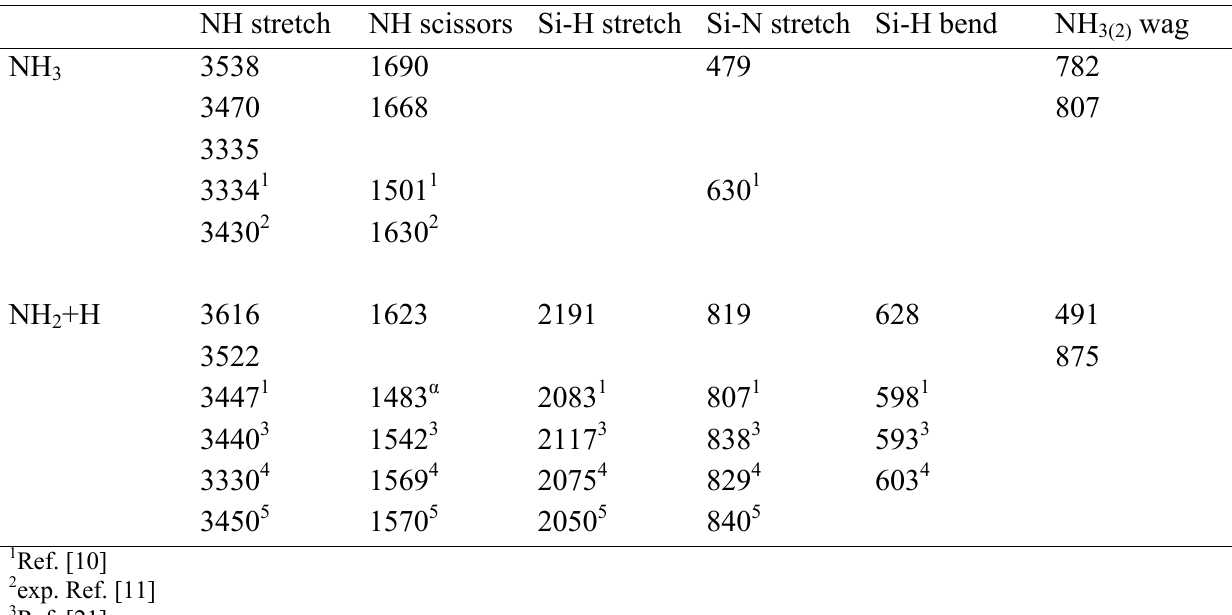
Table 2. Selected calculated and experimental frequencies (cm -1 ) of the adsorbed NH dissociative product on the Si(100)